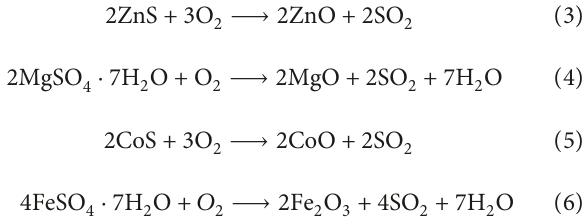
· 7H O (Figure 3(g)), except 4 2